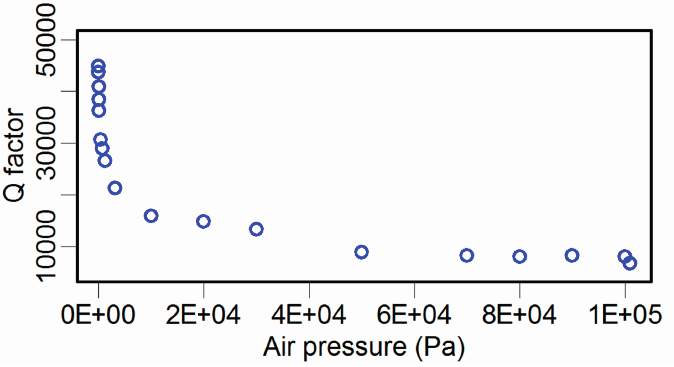
Figure 6. Atmosphere pressure vs. the Q factor of the TF.